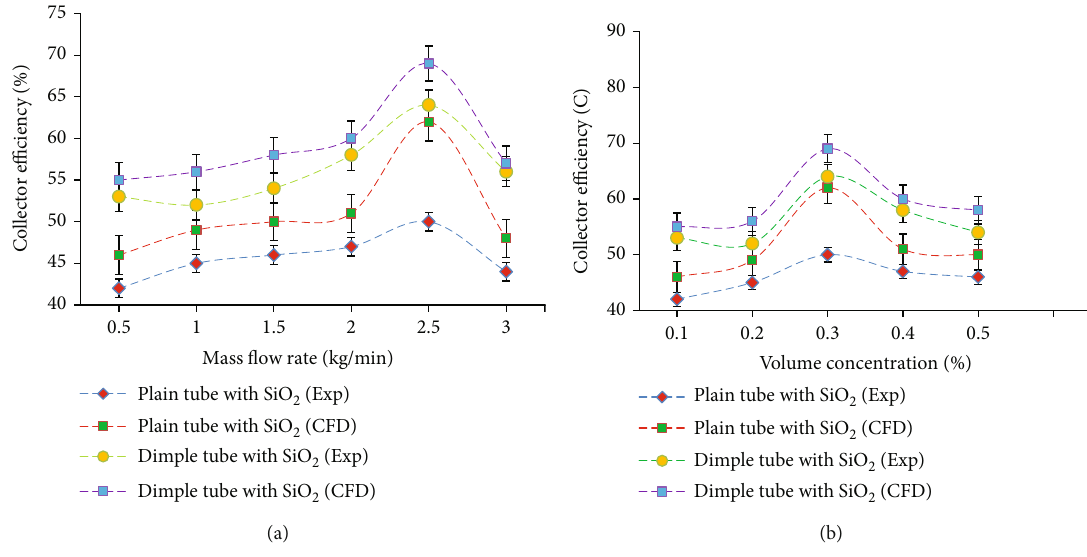
Figure 8: (a) Mass fl ow rate vs. collector e ffi ciency (%). (b) Volume concentration vs. collector e ffi ciency (%).